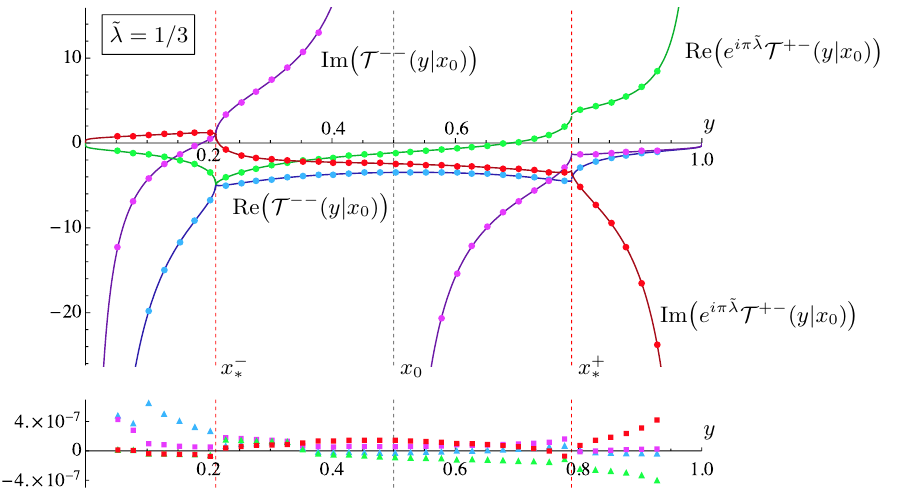
Figure 7 . Numerical verification of the integral equation (4.22) for the ansatz (4.31) for T ba ( y | x 0 ) with coupling e λ = 1 / 3 , at center-of-mass energy squared s = 6 (the physical mass m is set to 1) and incoming angle α = π corresponding to x 0 = 1 . The curves in color are given by the analytic 2 2 ansatz, while the dots are obtained by numerically integrating the r.h.s. of (4.22). The deviation between the two sides of the integral equation, for various components of the amplitude, is shown in the lower panels. As expected, T −− ( y | x 0 ) agrees with e iπ e λ T + − ( y | x 0 ) at y = x − . (Note that ∗ T −− ( y | x 0 ) also agrees with e − iπ e λ T + − ( y | x 0 ) at y = x + , not shown in the ∗